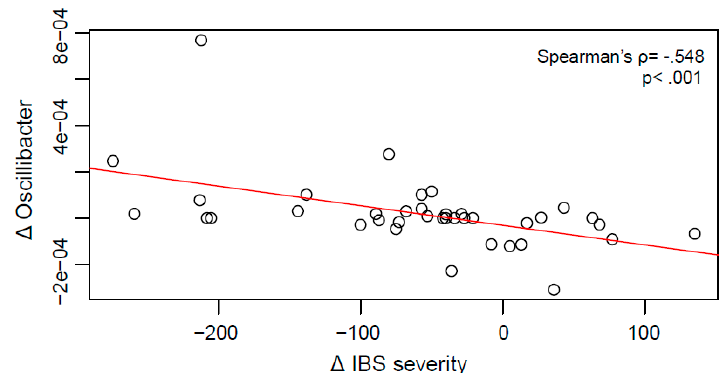
Figure 6. Scatterplot of the relation between changes in IBS severity and changes in abundance of the genus Oscillibacter pre-post GHT.